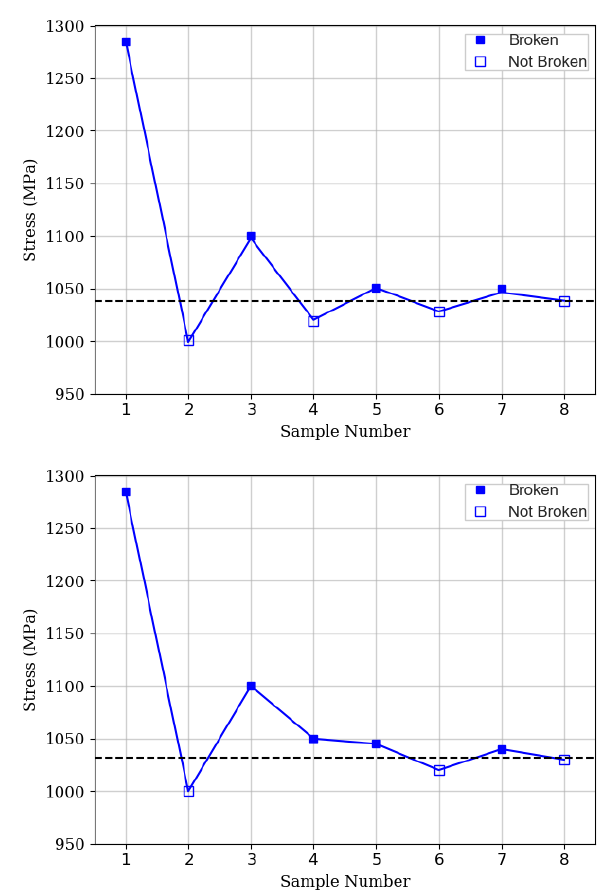
Figure 32: Endurance limit values for machined SLM IN718 for (a) dry machining and (b) flood cooling machining with emulsion-based coolant